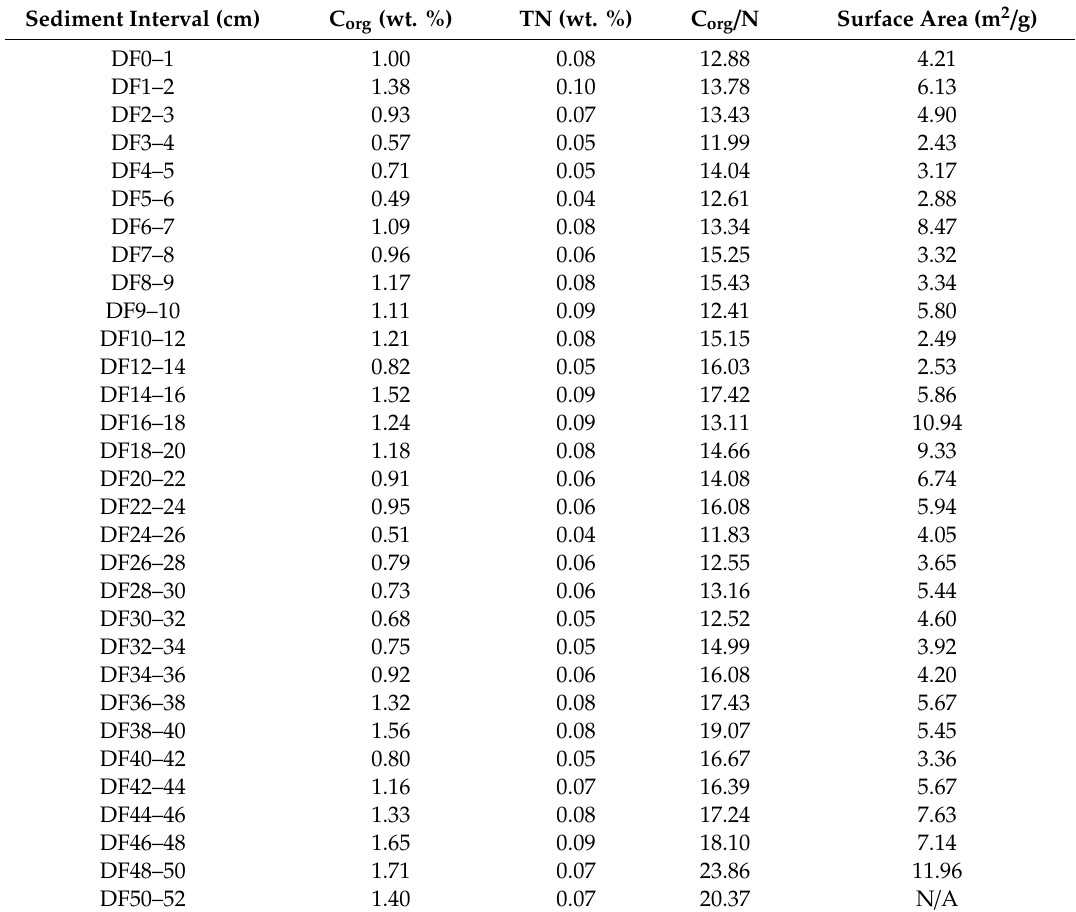
Table 3. Organic Carbon (C org ), Total Nitrogen (TN), Carbon / Nitrogen Ratio (Cor / N) and Surface